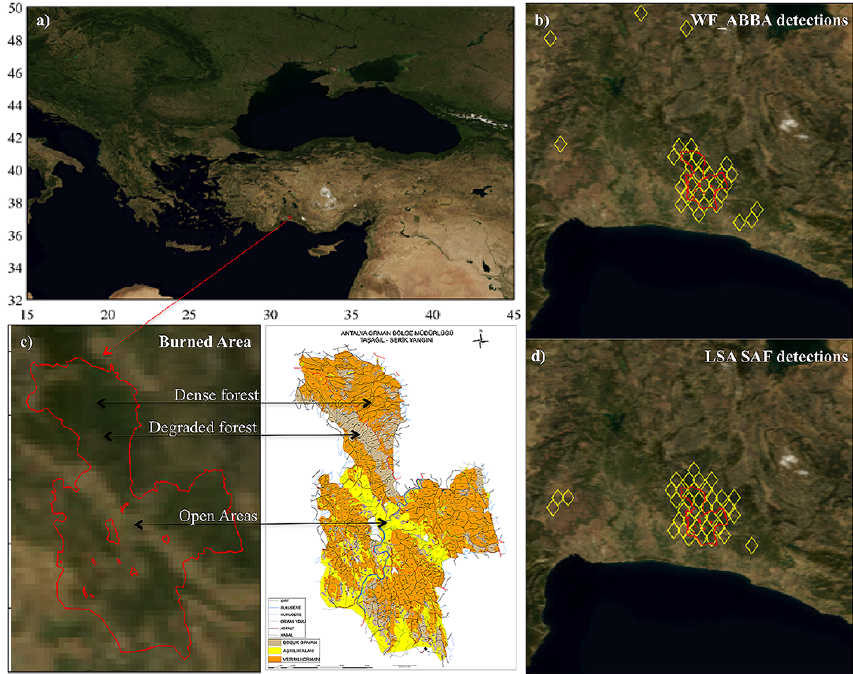
Figure 1. (a) Study area. (c) Burned area as reported by the Antalya forestry department (right) and over a MODIS Blue Marble image (left). (b) WF_ABBA (MSG-SEVIRI) detections of the Antalya fire. (d) LSA SAF (MSG-SEVIRI) detections of the Antalya